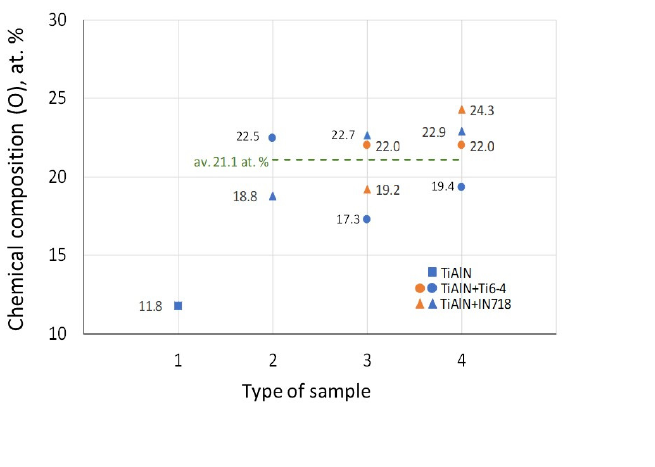
Figure 13. XRD analysis results of investigated coating after oxidation during machining tests.